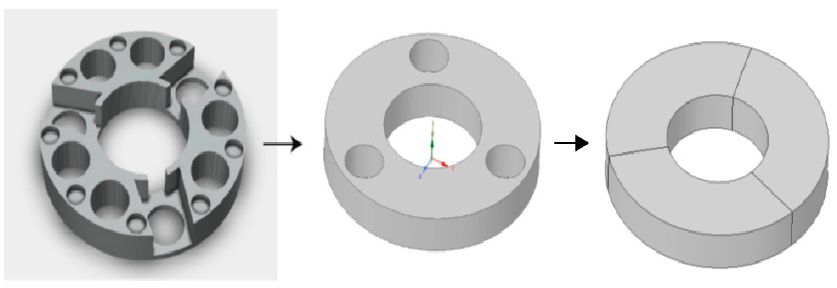
Figure 12. Simplifications in disk modeling. Source: authors. Figure 12. Simpli fi cations in disk modeling. Source: authors. Figure 12. Simpli fi cations in disk modeling. Source: authors.